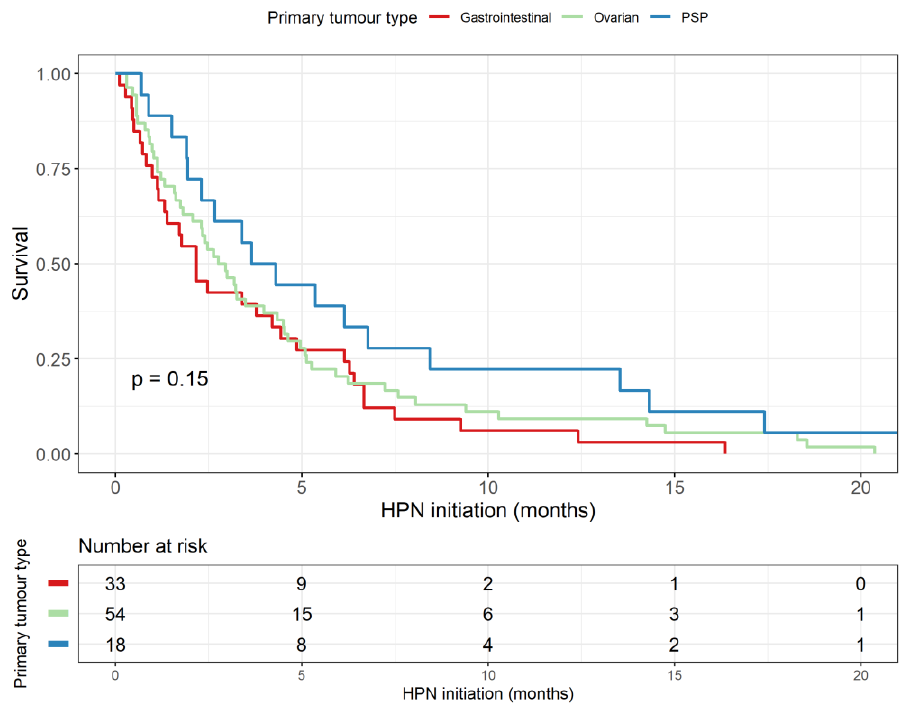
Figure 3. Survival curve stratified by the primary cancer types. PSP, pseudomyxoma peritonei.